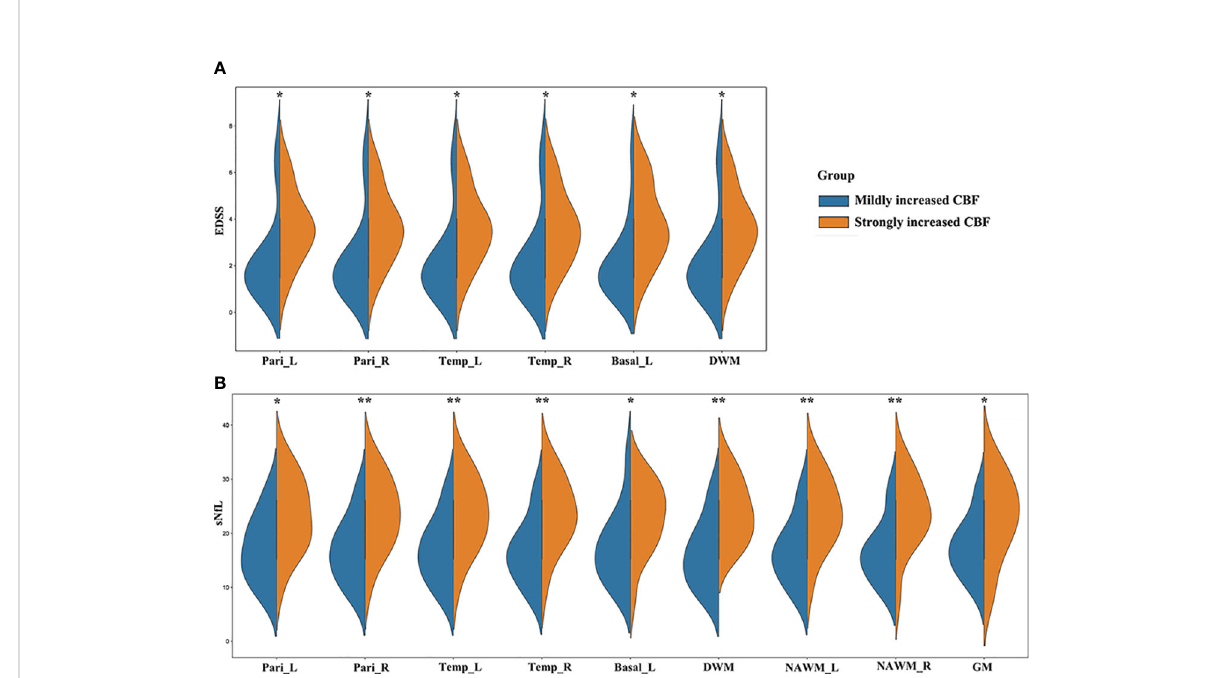
FIGURE 4 MS patients with different CBF values showed different clinical severity. (A) EDSS scores in MS patients with strongly increased CBF were signi fi cantly higher than those in patients with mildly increased CBF in the bilateral parietal lobes, bilateral temporal lobes, left basal ganglia, and